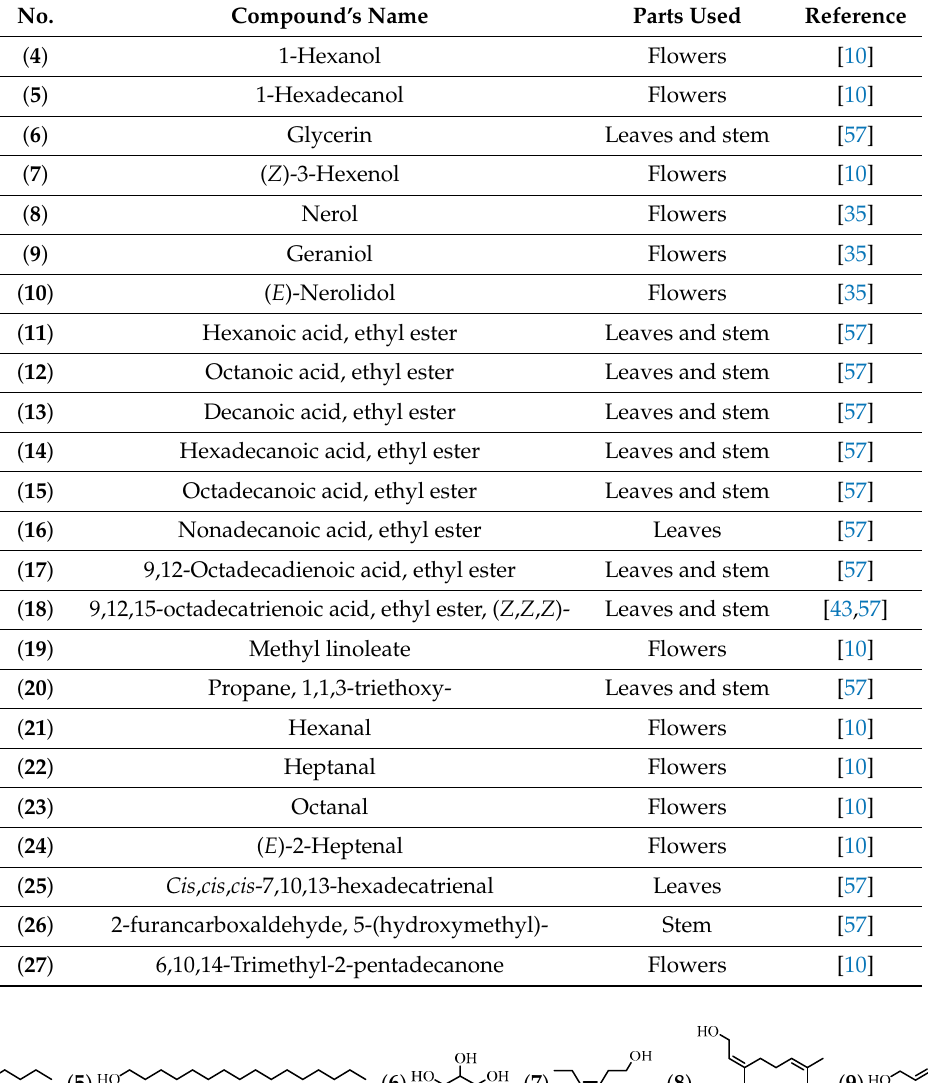
Table 2. The alcohols, esters, ethers, aldehydes, and ketones from A. cathartica. No.